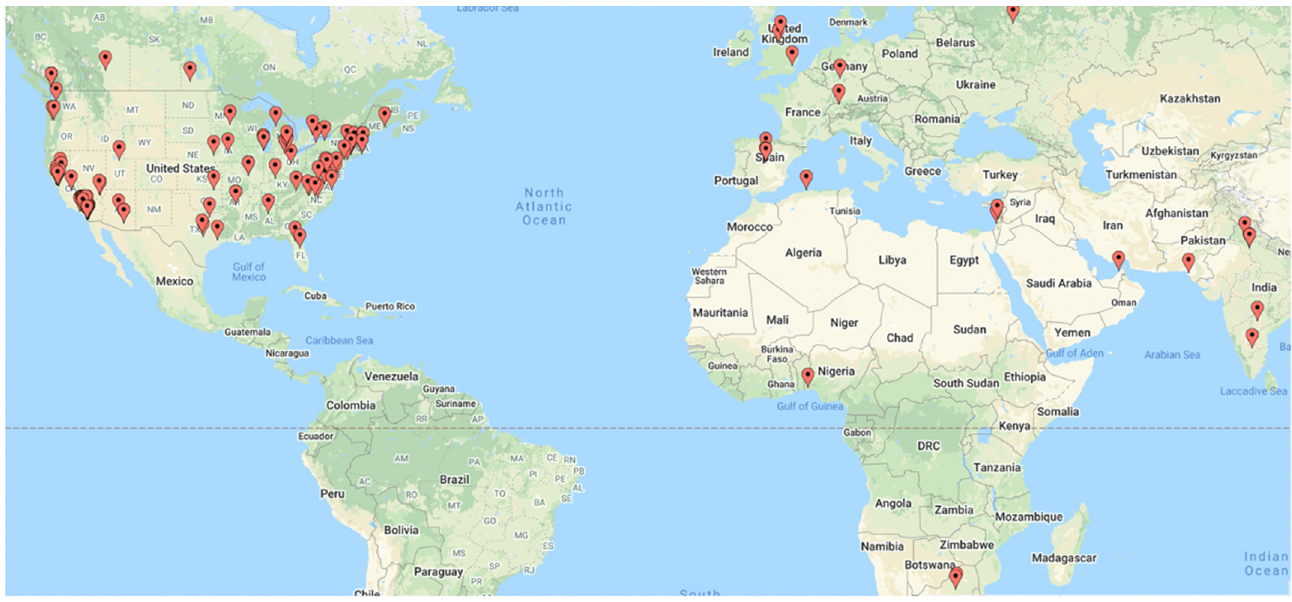
Figure 1. Locations of survey participants.